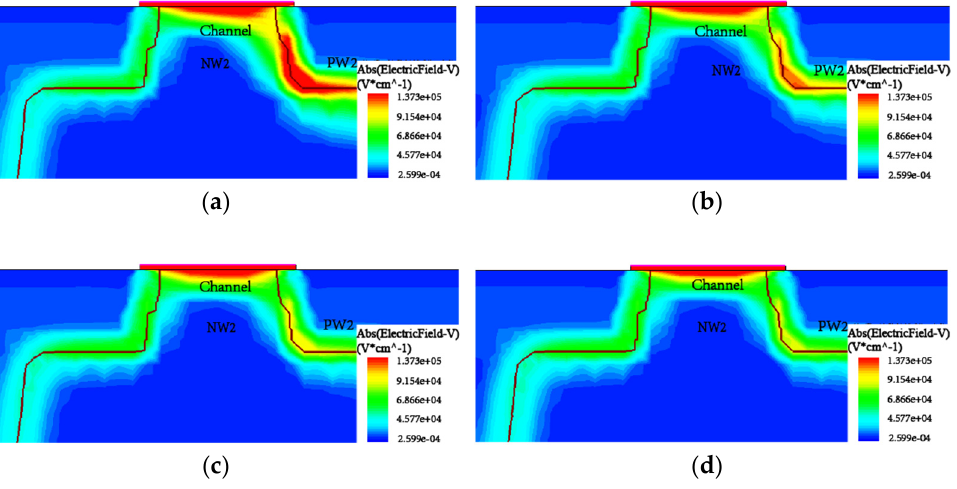
Figure 8. TCAD-simulated electric field distribution of PTBSCR (L = 0.5 μ m) when T1 is subject to a stress of I pulse = 75 μ A, T2 is grounded. The PTBSCR with ( a ) V G = 0 V, ( b ) V G = − 1 V, ( c ) V G = − 3 V, ( d ) V G = − 5 V.